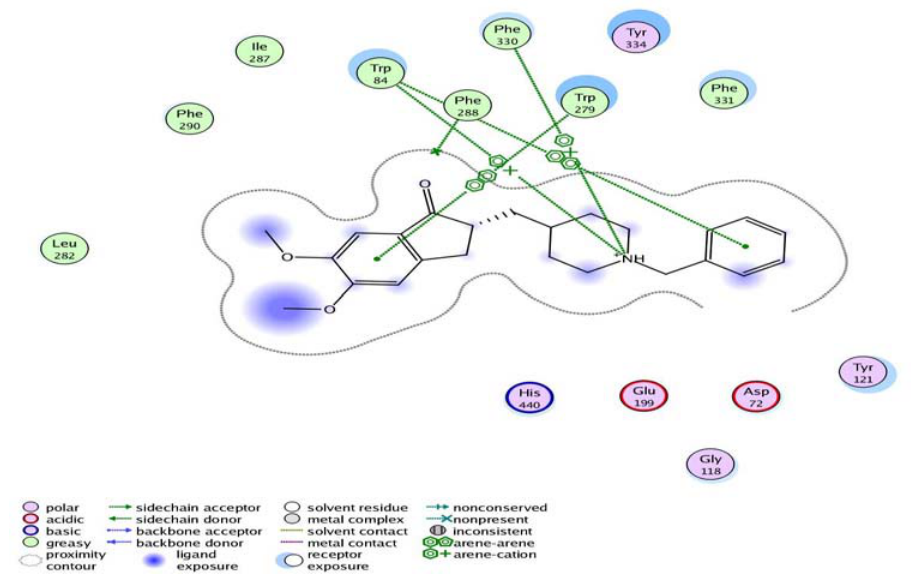
in the AChE binding site generated by MOE docking. d and the aromatic residues in the c